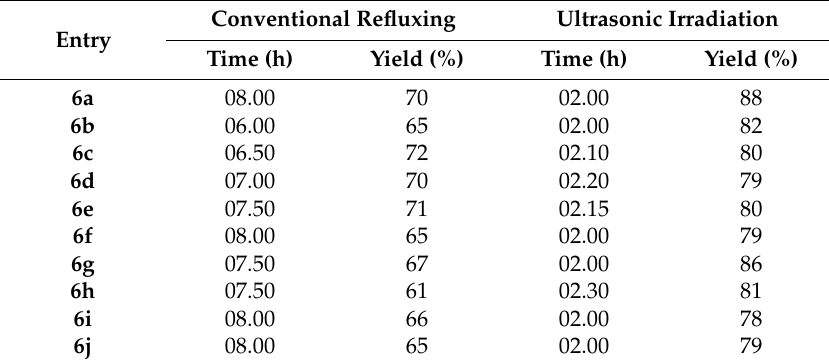
Table 2. Comparison of reaction kinetics of conventional refluxing and ultrasonic irradiation methods for the synthesized compounds 6a – j